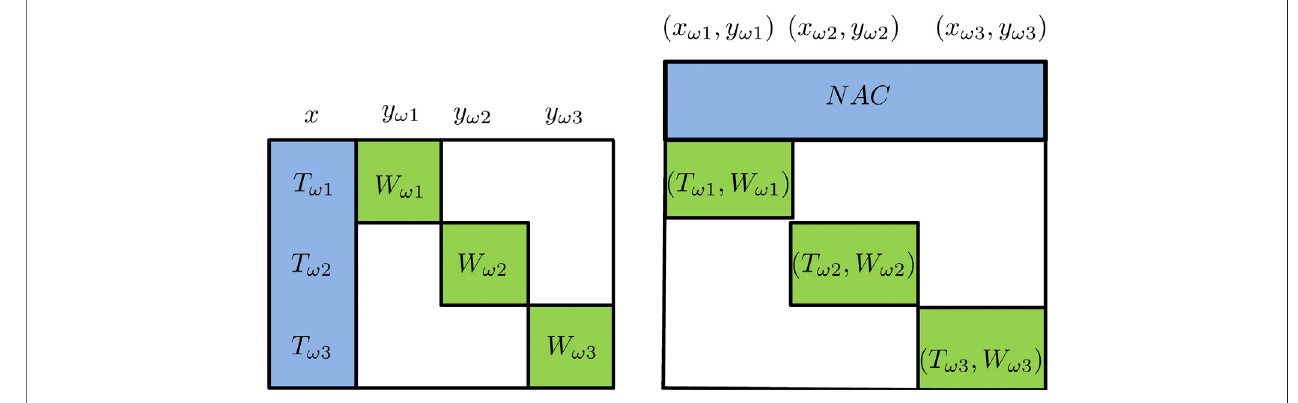
FIGURE 5 | Schematic view of Benders decomposition (left; variables x are “ complicating variables ” ), Lagrangean decomposition (right; the NACs are “ complicating constraints ”